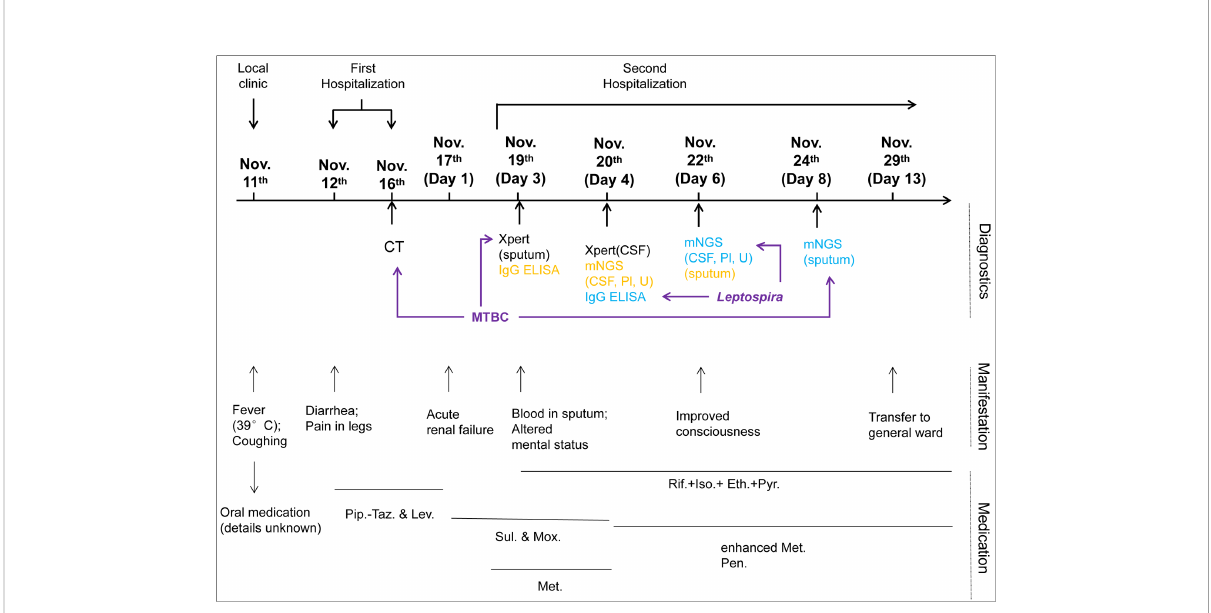
FIGURE 2 Clinical course of the patient during hospitalization. The schematic shows the timeline from the onset of symptoms (11 November 2021) to transferring to the general ward (29 November). Major events, including diagnostics, manifestations, and medication during the course, are indicated. Sample collection for diagnostics is indicated in yellow, and the dates of corresponding reports available are shown in blue. Diagnostic examinations used for pathogen identi fi cation are highlighted by purple arrows. CSF, cerebrospinal fl uid; Pl, plasma; U, urine; Pip.-Taz., Piperacillin sodium and tazobactam sodium for injection; Lev., Levo fl oxacin hydrochloride injection; Sul., sulperazone; Mox., moxi fl oxacin hydrochloride and sodium chloride injection; Met., methylprednisolone; Rif., rifampicin; Iso., isoniazid; Eth., ethambutol; Pyr., pyrazinamide; Pen.,